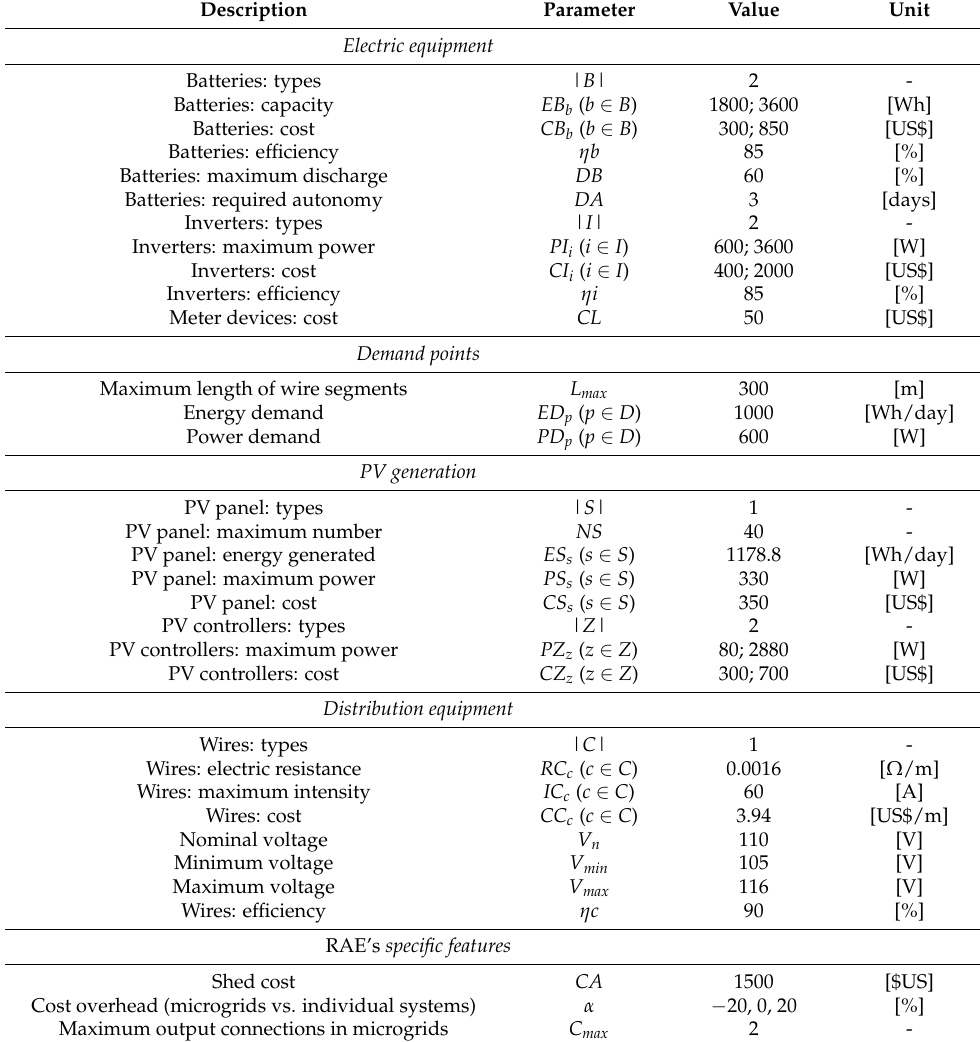
Table 4. Numerical values of the parameters shared by the three